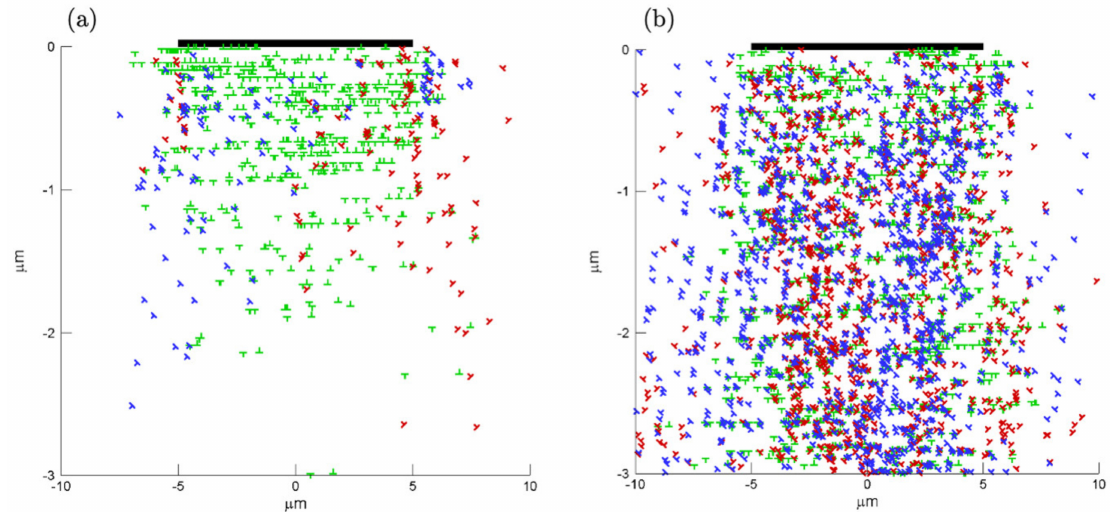
Figure 7. Effect of preceding indentation on dislocation structure. Dislocation patterns are obtained for U = 0.02 µ m of simulations ( a ) pure sliding with contact size a = 10 µ m ( b ) sliding with a preceding indentation that introduces a contact size a ≈ 10 µ